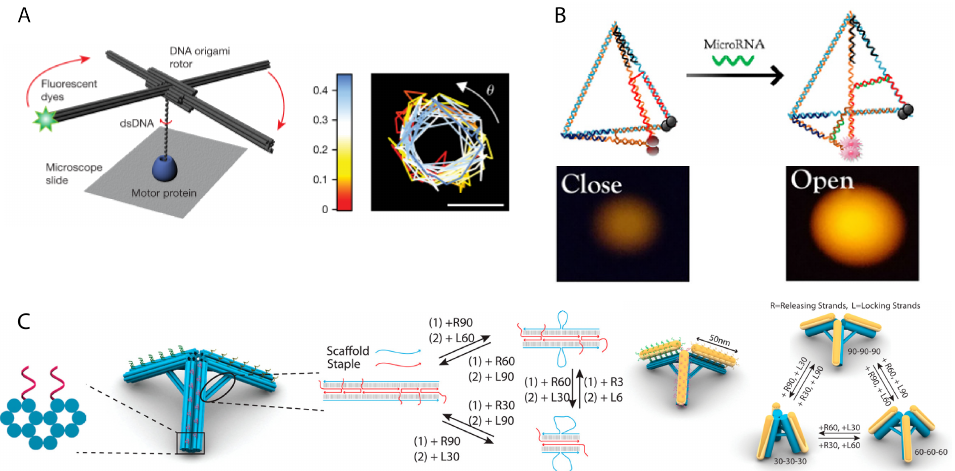
Figure 8. Applications of DNA nanomechanics. ( A ) A rotating DNA origami nanostructure with a fluorophore attached on the tip to track the activity of DNA rotation from genome-processing motor proteins (reprinted with permission from Springer Nature [171]); ( B ) A DNA tetrahedron that undergoes a physical change to generate a FRET-based signal in response to detecting an mRNA biomarker (reprinted with permission from AAAS [172]); ( C ) A tripod DNA nanostructure that can reconfigure the angles of its legs by swapping out ssDNA modules within the struts that span adjacent legs (reprinted with permission from American Chemical Society